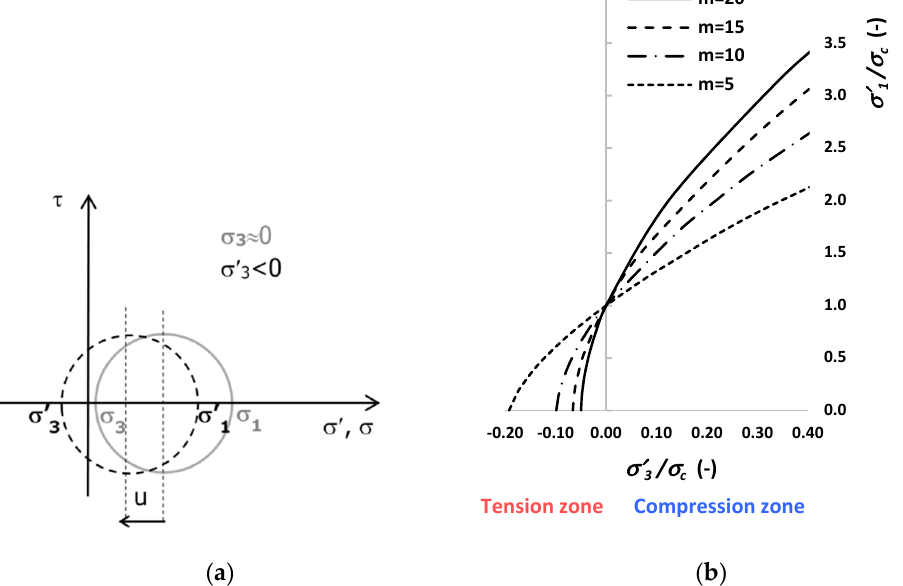
Figure 1. ( a ) Effect of the pore pressure close to the excavation boundary; ( b ) Variation of the strength with parameter m in the tension and compression zone.